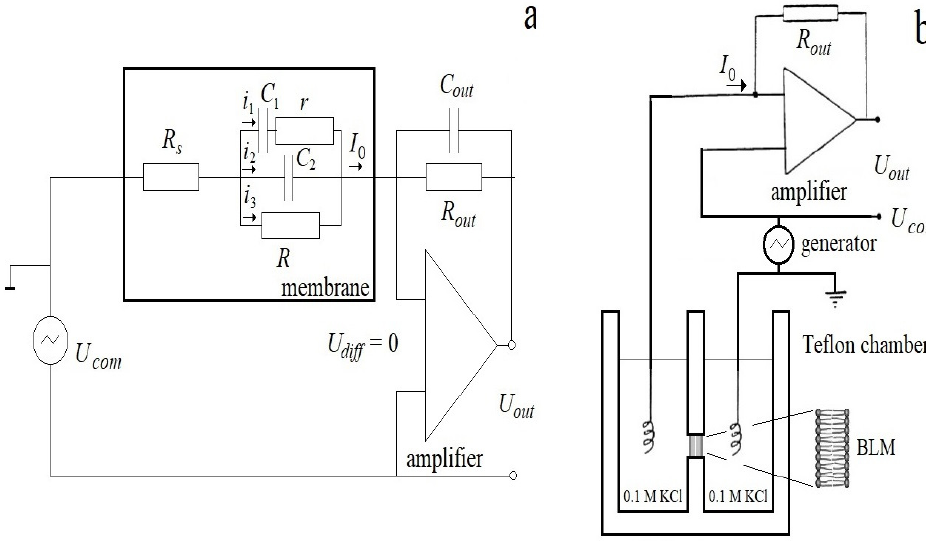
Figure 2. Equivalent circuit of the membrane ( a ) and measuring system ( b ).